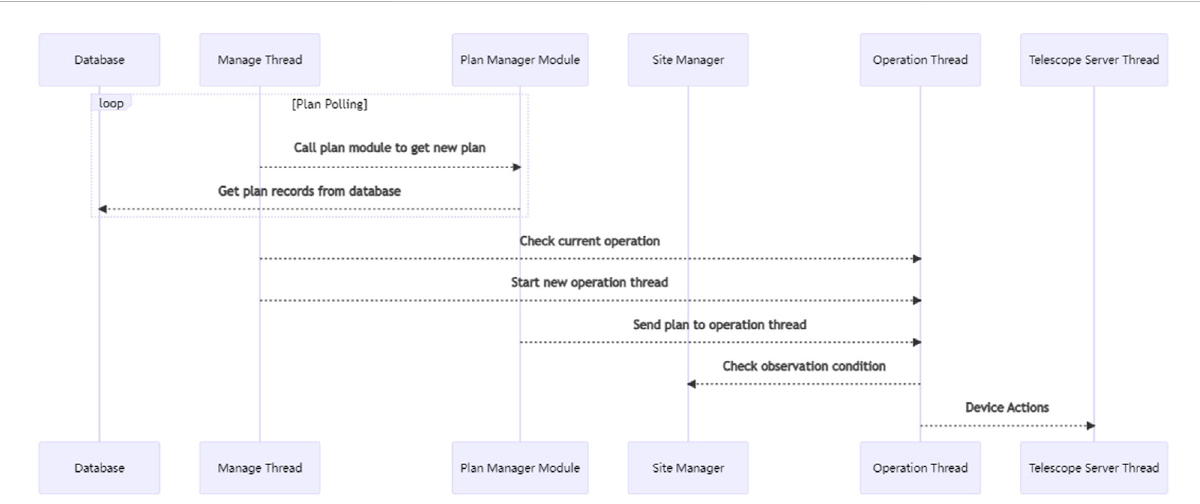
Observation plan life cycle. This shows a plan how to be acquired, performed, and which modules are involved, after the plan is inserted to the plandatabasebyuser.InadditiontothemodulesinTCS,thesitemanagerisinvolvedtoprovidetheobservationconditionrelatedtotheplan,suchas